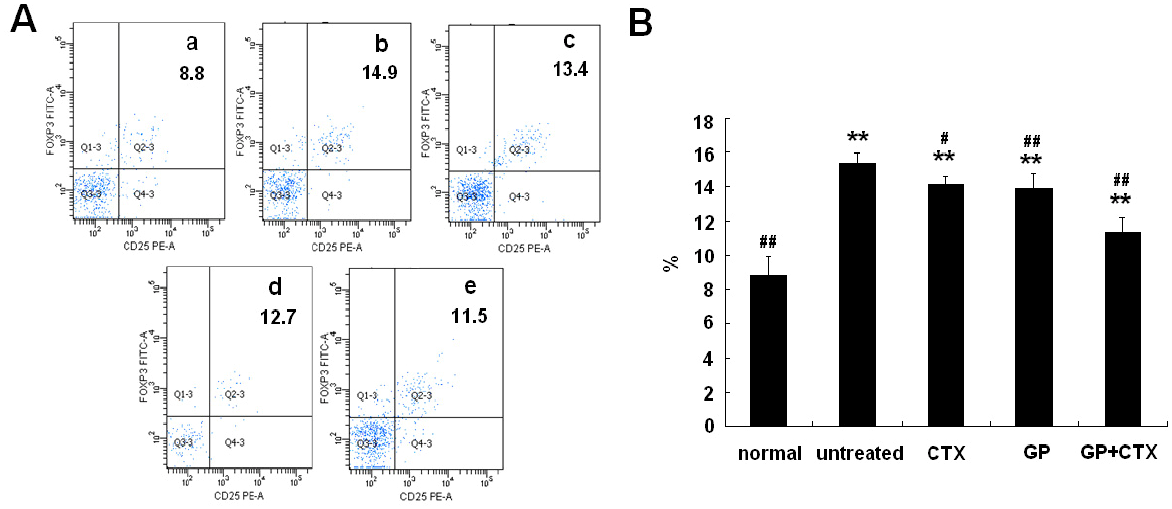
Figure 2. Effects of GP on the proportion of Treg cells in the lymph nodes of the tumor- bearing mice. ( A ) Flow cytometric results of the proportion of Treg cells in the lymph nodes. a: Normal control group; b: untreated control group; c: CTX group; d: GP group; and e: GP+CTX group. ( B ) Analysis of the proportion of Treg cells in the lymph node. The results are representative of three independent experiments. * P < 0.05, ** P < 0.01, vs. the normal control group; # P < 0.05, ## P < 0.01, vs. the untreated control